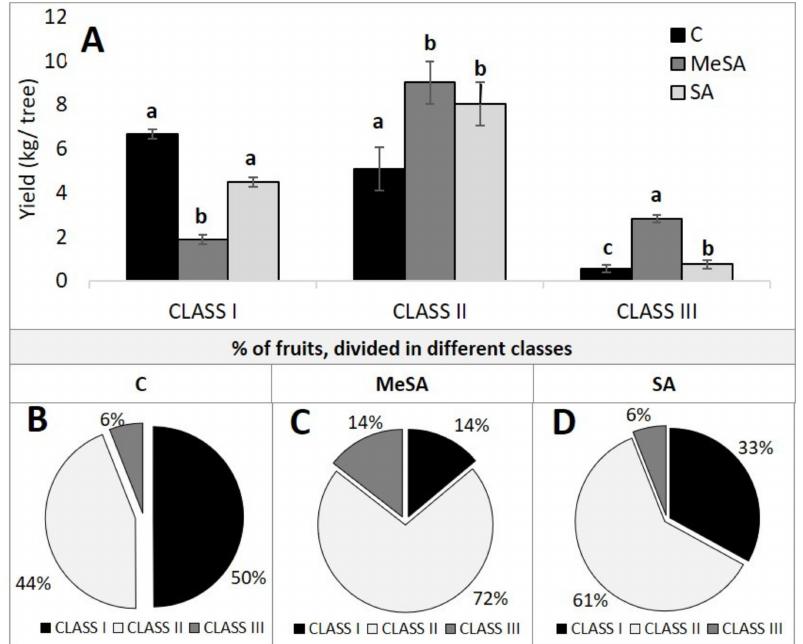
Figure 2. ( A ) Final yields of the apple fruit for the control ( C ), methyl salicylic acid (MeSA), and salicylic acid (SA) treatments, defined according to the three different quality classes. Data are means ± standard error ( n = 15). Different letters indicate significant differences among the treat- ments within each class ( p <0.05; Duncan tests). ( B – D ) Proportions of the apple fruit yields within each quality class for the control ( B , C ), methyl salicylic acid (MeSA) ( C ), and salicylic acid (SA) ( D ) treatments. Class I, >70% red blush; Class II, 50% to 70% red blush; Class III, <50% red